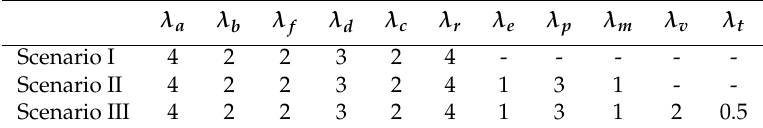
Table 6. The average transition triggering rate of Scenarios I/II/III.